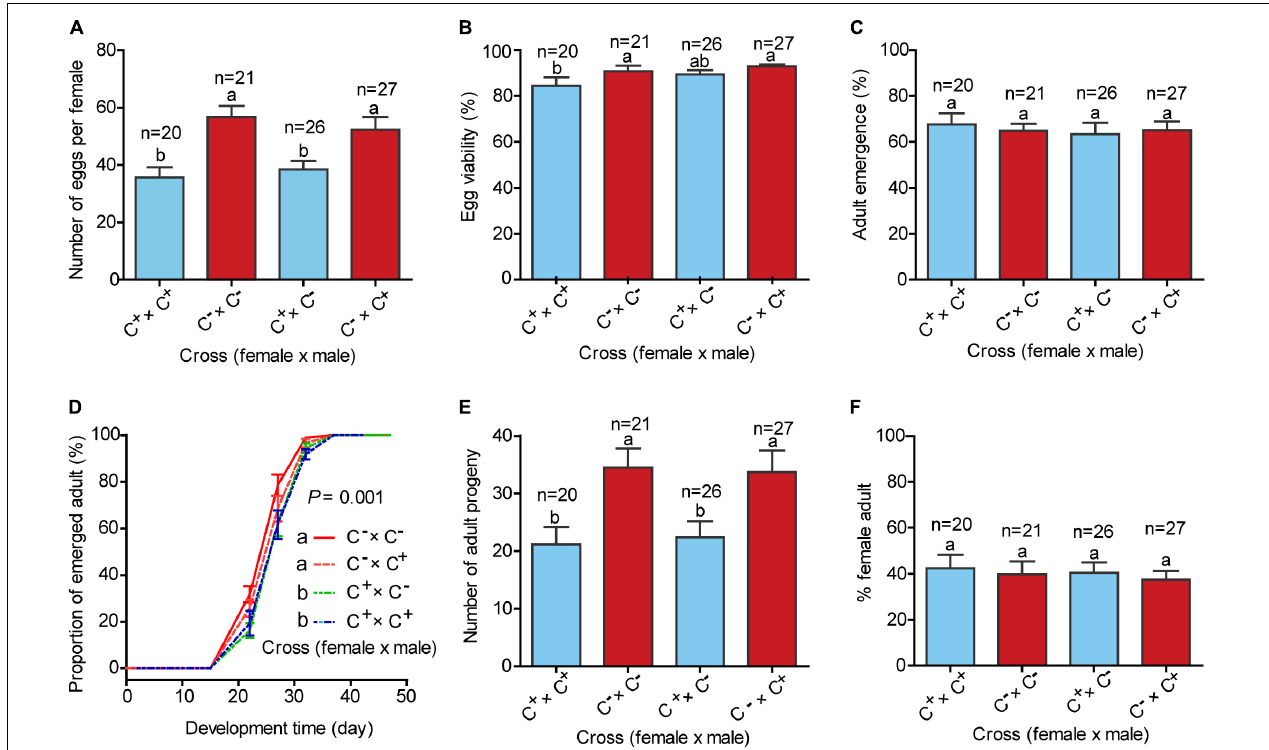
FIGURE 3 | Life history parameters of four treatments of mating between C + and C − whiteflies. (A) Mean number of eggs per female produced in 7 days; (B) Percentage of eggs that hatched; (C) Proportion of survival from the 1st instar nymph to adulthood; (D) Development time of progenies from egg to adulthood, expressed as the cumulative proportion of adult emergence; (E) Number of progenies that survived to adulthood; (F) Sex ratio of the adults. C + : the MED whitefly line harboring Portiera , Hamiltonelle and Cardinium ; C − : the MED whitefly line harboring Portiera and Hamiltonelle but not Cardinium . In each replicate of the four treatments of mating, a female and a male were reared together to mate and oviposit for 7 days. Developmental curves were analyzed with the Cox proportional-hazards model tests, and other data were analyzed with one-way ANOVA followed by LSD test for multiple comparisons. The data are mean ± SEM, and the different letters indicate significant differences at P <